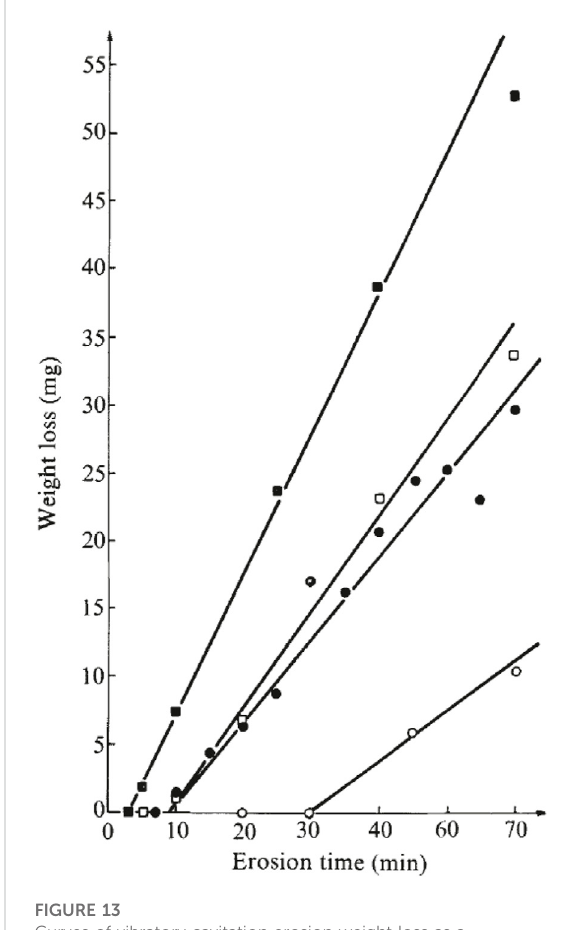
FIGURE 13 Curves of vibratory cavitation erosion weight loss as a functionoftimeforcoppersecimens(AshworthandProcter,1975) in: C , distlled water; □ , equilibrated 100 w. p.p.m polyacrylamide solution; ■ , equilibrated 1,000 w. p.p.m polyacrylamide solution; ○ , 2:3 v/v glycerol-distilled water